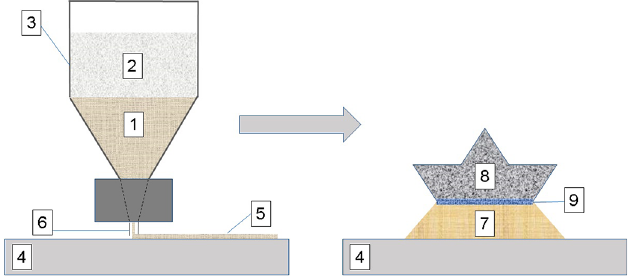
Fig. 5. Schematic view of hybrid PBF process using EBM system: 1-powder #1; 2 – powder #2; 3 – powder hopper for small amounts of powder; 4 – building platform; 5 – deposited powder layer; 6 – rake blades for powder deposition; 7 – part built from powder #1; 8 – part built from powder #2; 9 – gradient zone built from blended powder